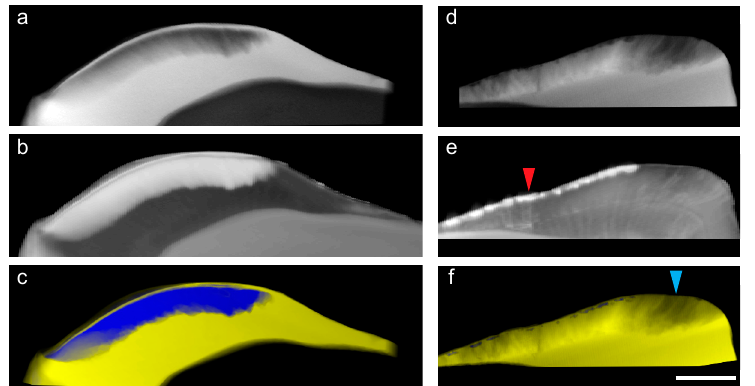
Figure 6. Images ( a , d ) show the lateral µCT attenuation values integrated across the slice thickness. The mean scattered intensities for the natural ( b ) and the artificial lesions ( e ) for the q -range correspond to the real-space periodicities between 5 and 150 nm. The thicknesses of the lesion in blue color and of sound enamel in yellow color are given in ( c , f ). Brighter color indicates larger thickness, being black for zero and bright yellow/blue for 1330 µm ( c ) and 413 µm ( f ), respectively. Mixed colors indicate regions where unaffected enamel and caries are present along the X-ray beam ( z -direction, cf. Figure 1). The scale bar corresponds to 1 mm.